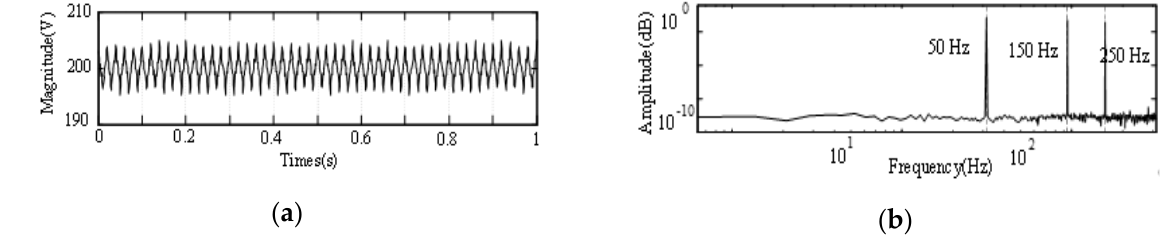
and spectrum of the input DC voltage.